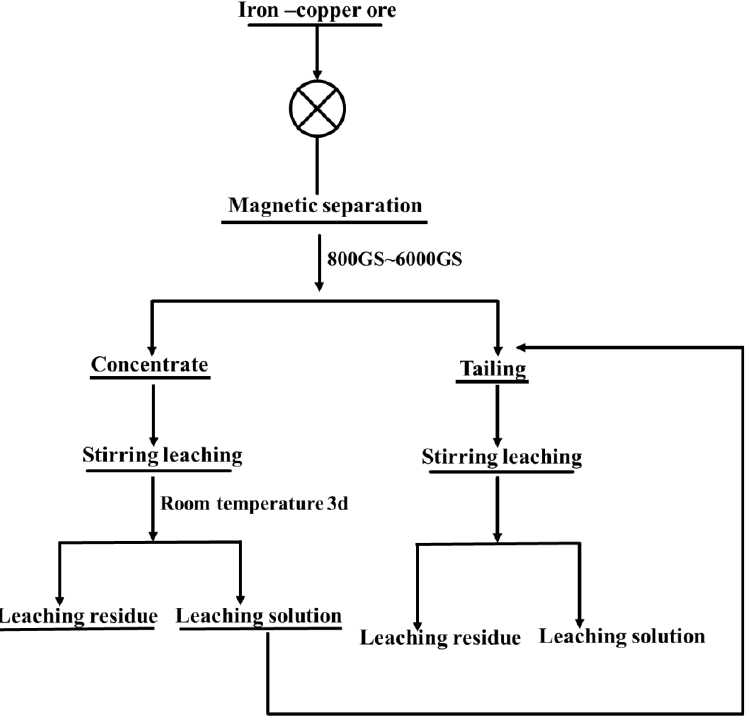
Figure 11. Leaching process flow chart of the COBL ore.